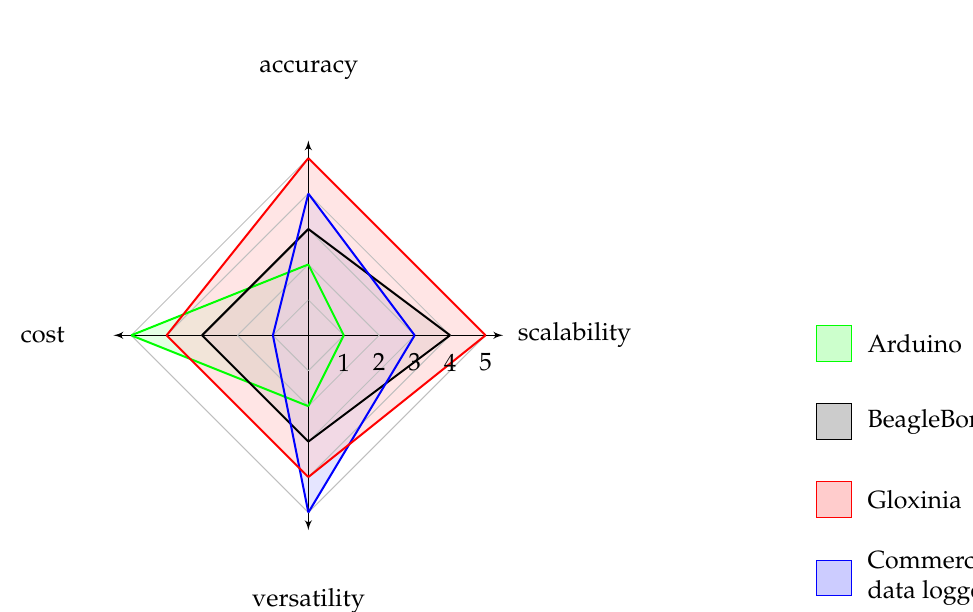
Figure 9. Spider chart comparing different data logging approaches. The higher the number, the better the performance for this specific metric. For instance, a score of 5 on the cost scale means this has the best cost performance, i.e., lowest